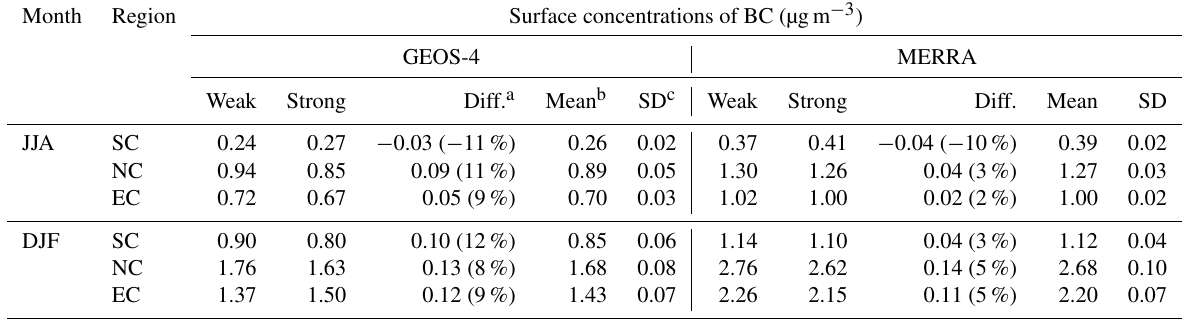
Table 2. Simulated JJA (DJF) mean surface BC concentrations (µgm − 3 ) in the 5 weakest and 5 strongest EASM (EAWM) years during 1986–2006. Results are from simulations VMETG4 and VMET averaged over northern China (NC; 110–125 ◦ E, 28–45 ◦ N), southern China (SC; 110–125 ◦ E, 20–27 ◦ N), and eastern China (EC; 110–125 ◦ E, 20–45 ◦ N).